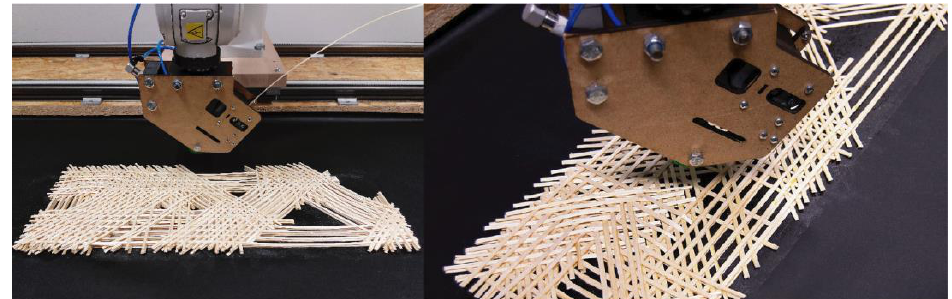
Figure 1. Robotic fiber laying process with processed willow strips from the research project TETHOK — Textile Tectonics for Wood Construction, University of Kassel.